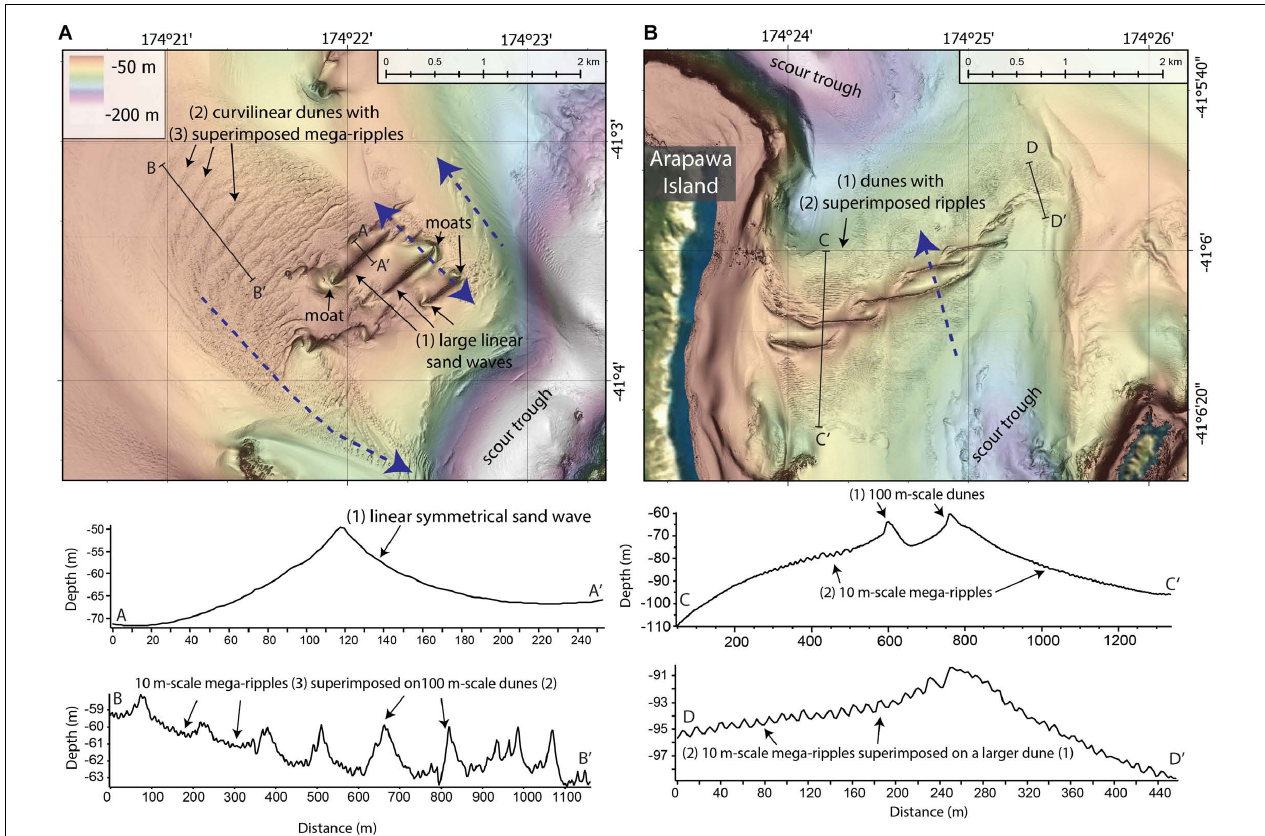
FIGURE 9 | Detailed view of sediment wave fields that lie to the NW (A) and SE (B) of the submarine ridge extending from Arapawa Island. For locations of sediment wave fields see Figure 8 . Navy blue arrows show the dominant transport direction as interpreted from seafloor geomorphology. Locations of profiles are shown. Features are labeled as described in the text. Profiles A-A’ shows the profile morphology of the linear symmetrical sediment wave, Profile B-B shows mega-ripples superimposed onto larger dunes, Profiles C-C’ and D-D’ shows asymmetrical en echelon dunes with superimposed symmetrical